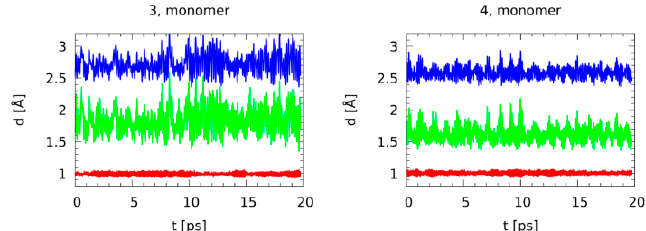
Figure 6. Time evolution of the H-bridge metric parameters. The CPMD gas phase simulations of the monomeric 3 and 4 . Red: Donor-proton distance, green: Proton-acceptor distance, blue: Donor-acceptor distance.